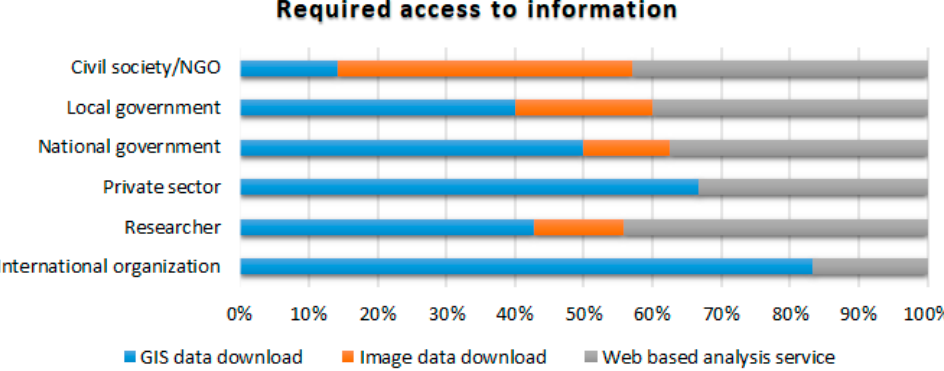
Figure 14. Results of the online expert survey, desired method of access to deprived area data (multiple answers).